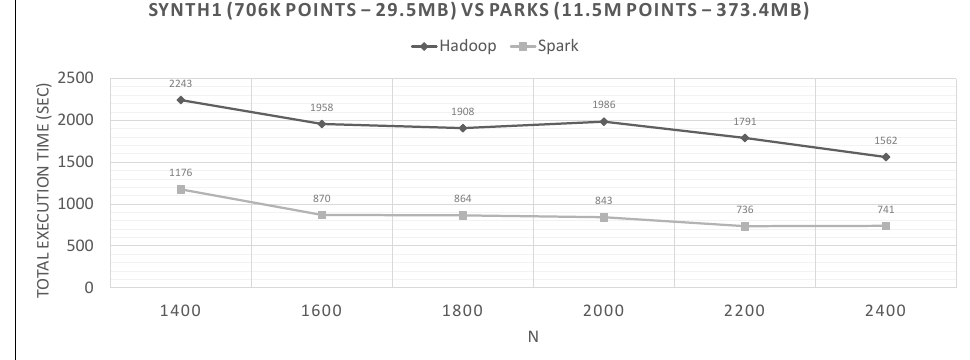
Figure 20. Hadoop vs. Spark, small synthetic query and small training datasets.